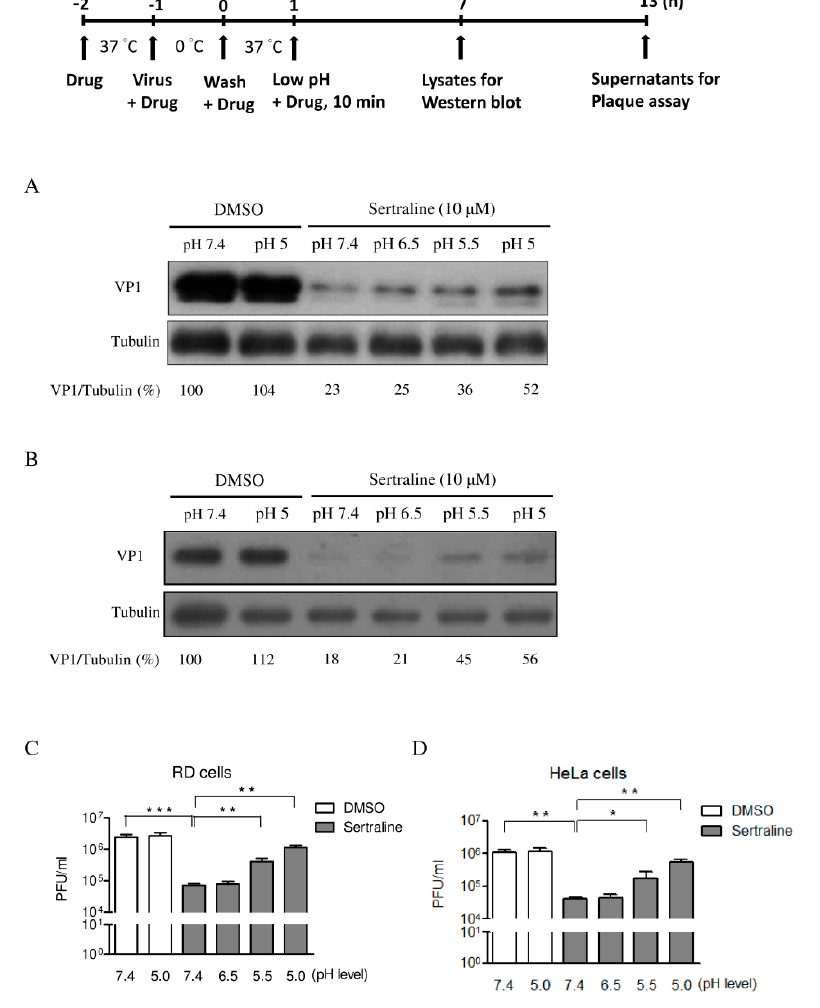
Figure 6. Exposure of the cells to low pH alleviated the antiviral activity of sertraline. The low-pH exposure assay with the schematic representation. ( A , C ) RD and ( B , D ) HeLa cells were pretreated with 10 µ M sertraline for 1 h. EV71 was used to inoculate the pretreated cells at an MOI of 1 in the presence of 10 µ M sertraline on ice for 1 h. The supernatant containing unbound virus was removed, and the cells were incubated with medium containing 10 µ M sertraline at 37 ◦ C for 1 h. The cells were incubated with media with different pH values (7.4, 6.5, 5.5, and 5.0) that contained 10 µ M sertraline for 10 min and then replaced with 10 µ M sertraline-containing medium (pH 7.4). ( A , B ) At 6 h after the addition of the media with the different pH values, levels of viral VP1 protein and tubulin (the internal control) were measured by Western blot. The percentage shown below each lane represents the intensity of viral VP1 relative to that of tubulin. ( C , D ) At 12 h after the addition of the media with the different pH values, viral titers from the supernatants were titrated by plaque assay. Triplicated experiments were conducted (* P < 0.05; ** P < 0.01; *** P < 0.001).